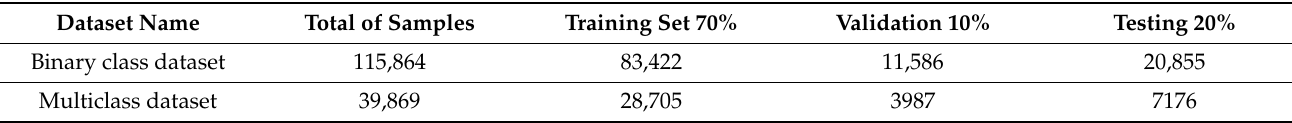
Table 2. Splitting of the datasets.